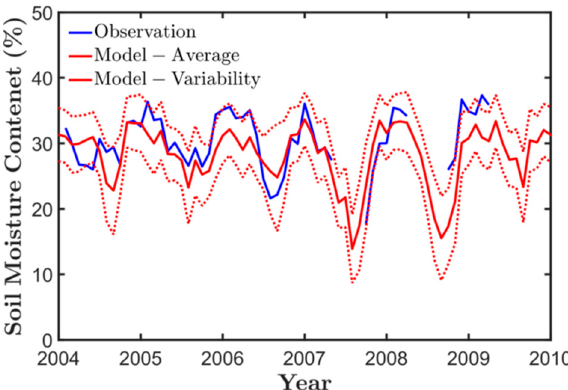
Figure 8. Validation of monthly soil moisture for the whole watershed. The model average and variability represents, respectively, spatially averaged monthly flux, and the spatial standard deviation.